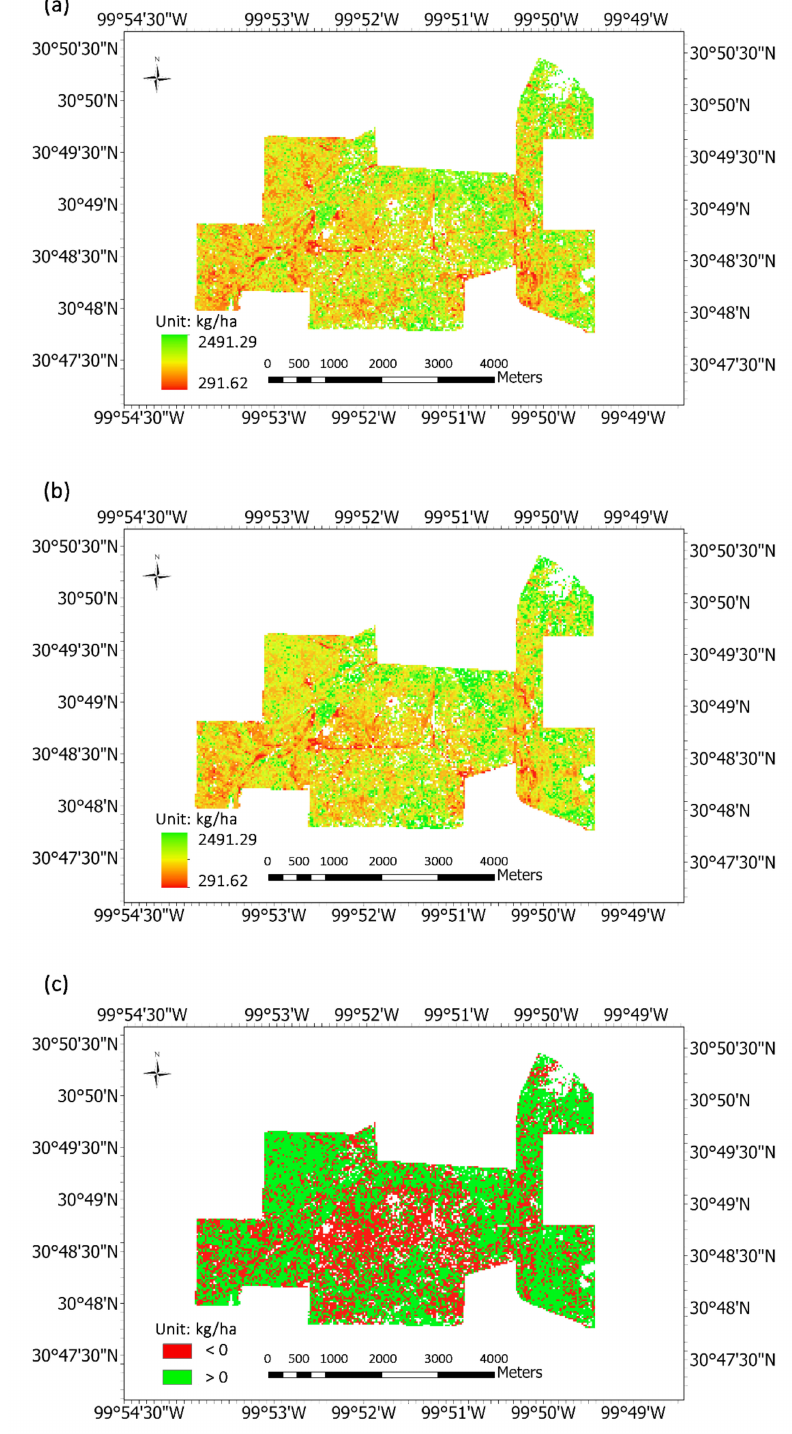
Figure 5. Biomass maps based on medium spatial resolution images: ( a ) biomass map without fractional cover as explanatory variables, ( b ) biomass map with fractional cover as explanatory variables, and ( c ) the differences in biomass between the maps with and without fractional cover as explanatory